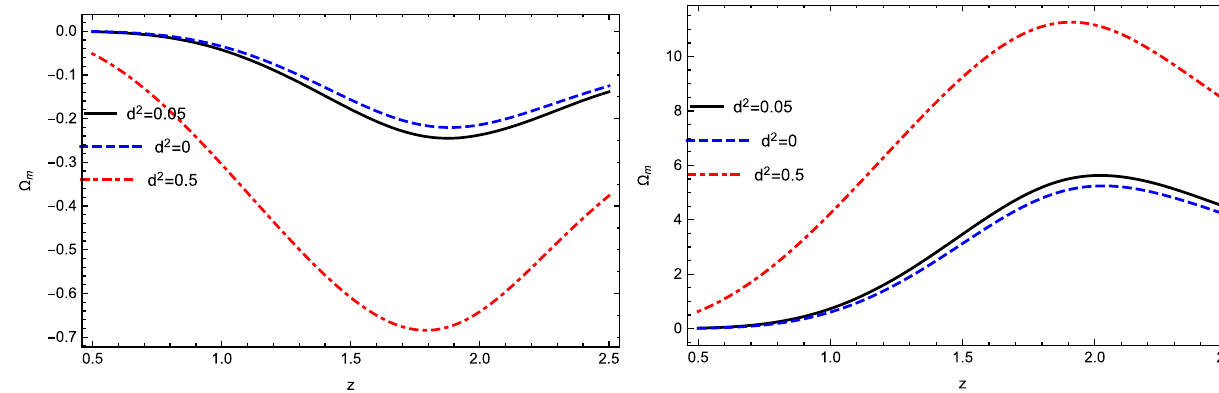
Fig. 1 Plot of (cid:9) m verses z for u = 1 and u = 2 . 002 for Bianchi type-III model